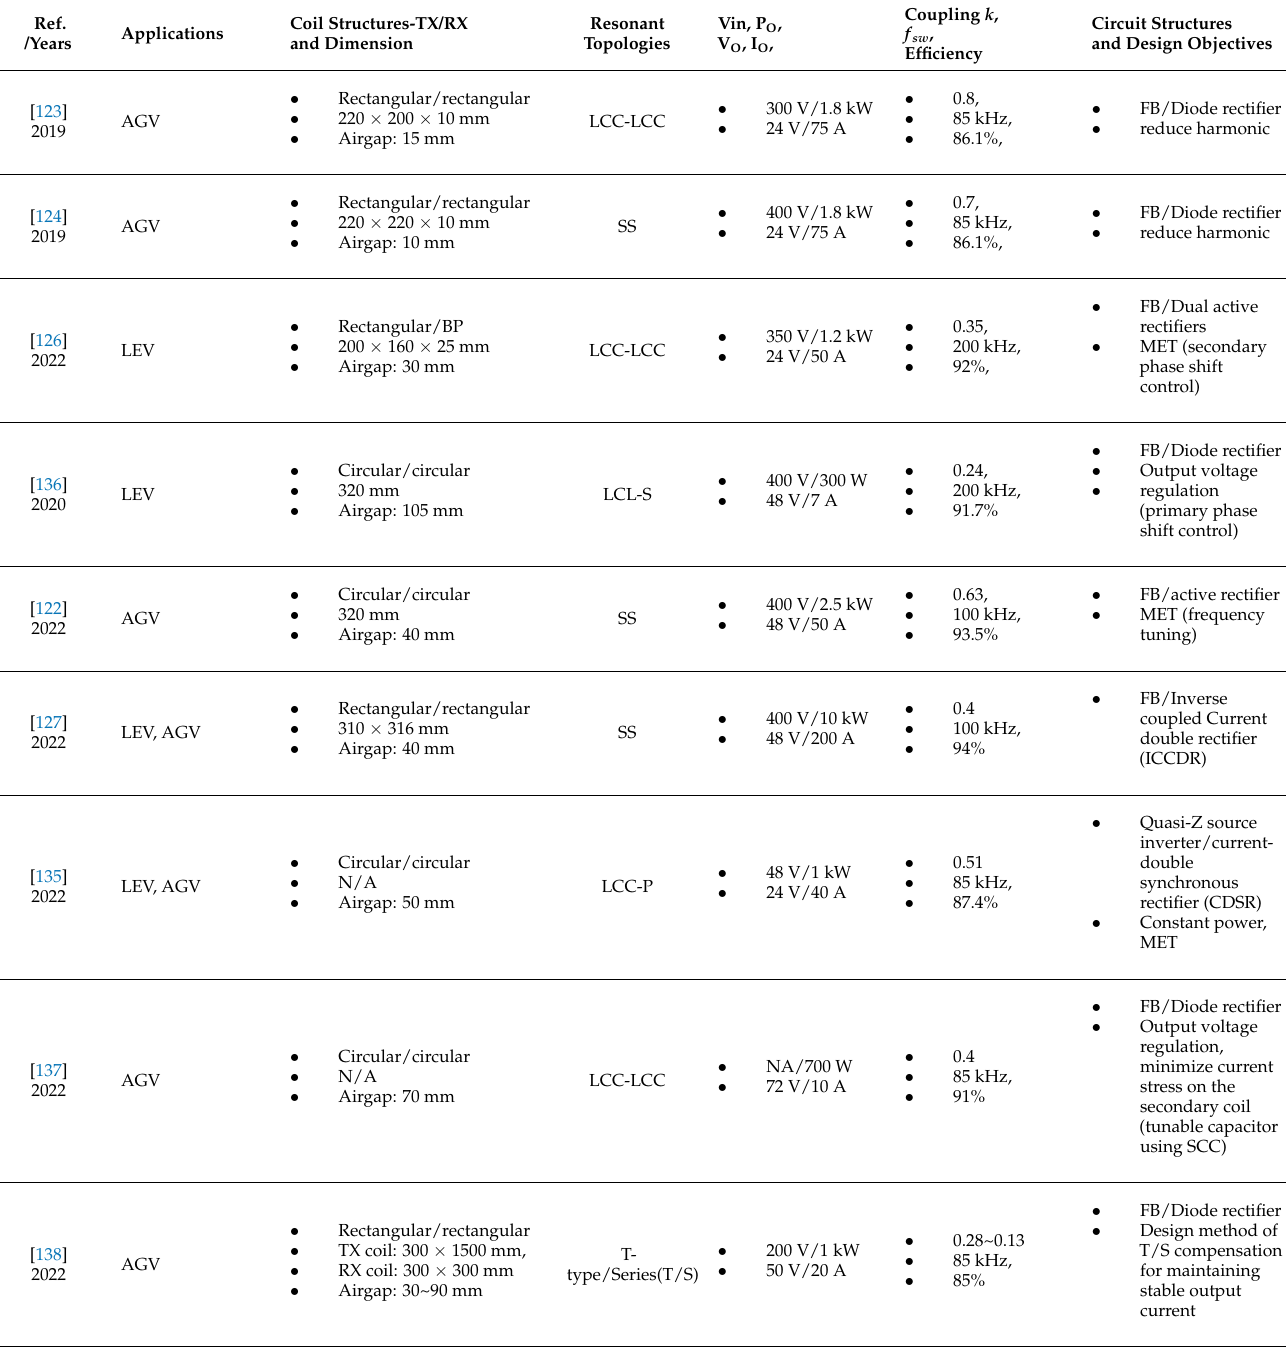
Table 7. Recent studies on wireless power transfer systems for low-voltage and high-current applications. Ref.